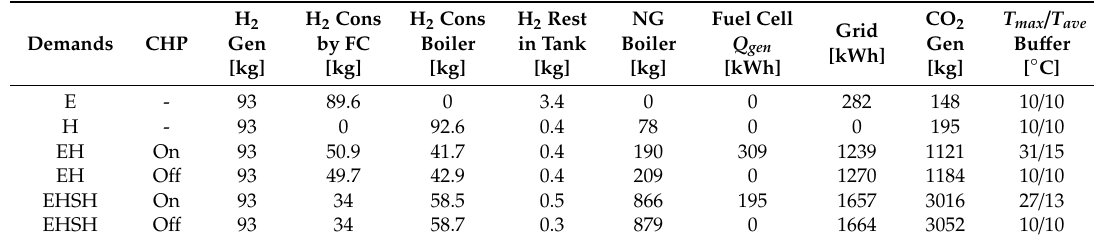
Table 7. System analysis with